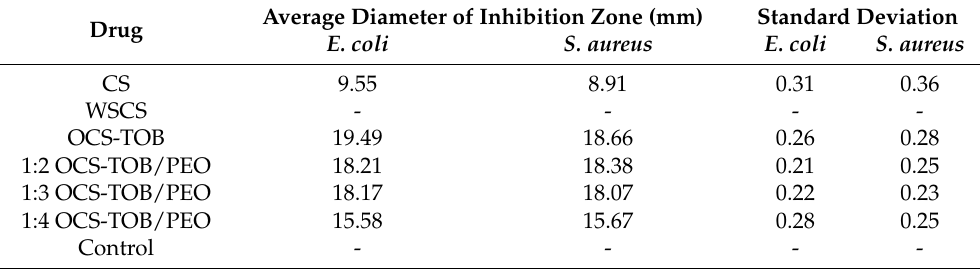
Table 2. Average inhibition sizes of CS, WSCS, OCS-TOB and different ratios of OCS-TOB/PEO sub micro-fibers against E. coli and S. aureus